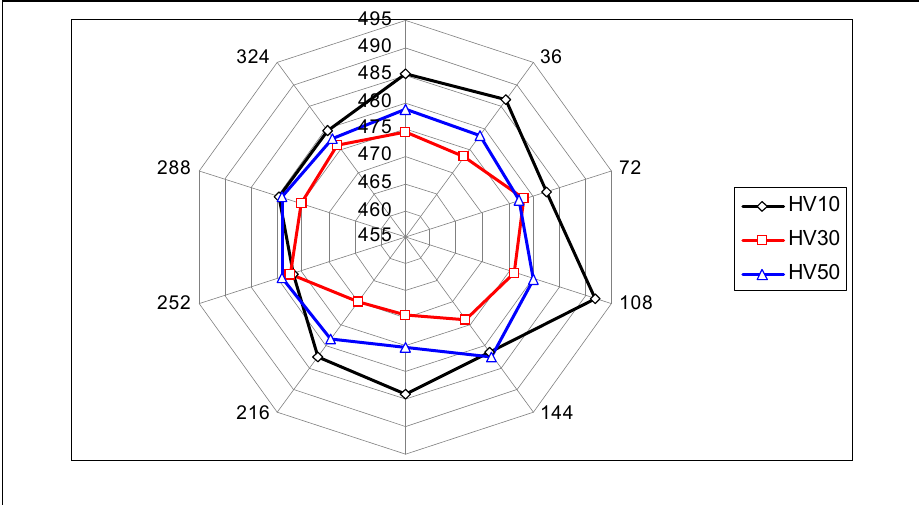
Figure 1 - The influence of the rotation of indenter in the hardness The certified reference material (CRM) in form of hardness reference block with specified hardness H = 472.4 HV10 and expanded uncertainty U c HV10 (coverage factor k = 2) was used as a standard for indirect calibration according to standard (STN EN ISO 6507-2:2005). The test forces/loads 98.07 N (HV10), 294.2 N (HV30) and 490.3 (HV50) were